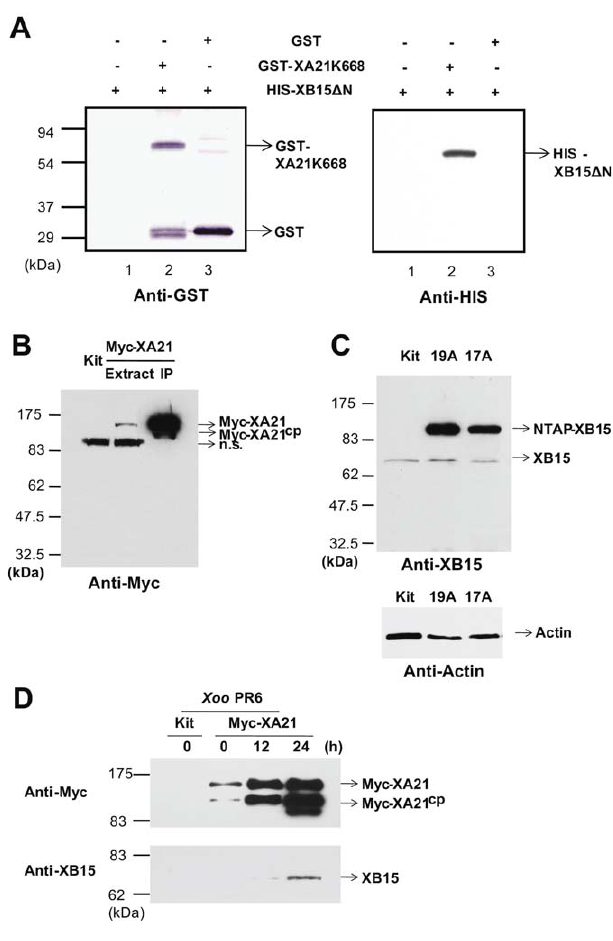
Figure 8. XB15 Interacts with XA21K668 In Vitro and In Vivo (A) HIS-XB15 D N was incubated with either glutathione alone (lane 1), glutathione-bound GST-XA21K668 (lane 2), or GST (lane3) in buffer containing 2 mM MgCl 2 . After washing three times, proteins were eluted with 2 3 sample buffer, and analyzed by SDS-PAGE and immunoblotting with anti-GST or anti-HIS antibody. The experiment was repeated three times with similar results. (B) Immunodetection of Myc-XA21 protein in transgenic plants carrying Myc-Xa21 under control of its native promoter before (Extract) and after immunoprecipitation (IP). Myc-XA21 and Myc-XA21 cp give bands at approximately 140 and 100 kDa, respectively, corresponding to the predicted mass of each protein [42]. A nonspecific band (n.s.) of 95 kDa was detected. (C) Immunodetection of XB15 in Kitaake (Kit) and transgenic plants overexpressing NTAP-XB15 (17A and 19A). Anti-XB15 antibody detected at band of about 70 kDa of XB15 in Kit and of 95 kDa of in NTAP-XB15 in expressing plants (17A and 19A). Anti-actin antibody was used as a loading control. (D) Co-immunoprecipitation of XB15 and XA21 after Xoo PR6 inoculation. XA21 was detected after immunoprecipitation with agarose conjugated anti-Myc antibodies. Total protein extracts from 15 g of leaf tissue of Kitaake (Kit), mock-treated Myc-XA21, and Xoo PR6-inoculated Myc-XA21 at the indicated time points were incubated with anti-Myc antibody to immunoprecipitate XA21 complex. The precipitates were used for protein gel blot analysis using anti-Myc antibody (top) or anti-XB15 antibody (bottom). Myc-XA21 and Myc-XA21 cp give bands at about 140 and 100 kDa, respectively, and XB15 is detected as a band of 70 kDa.